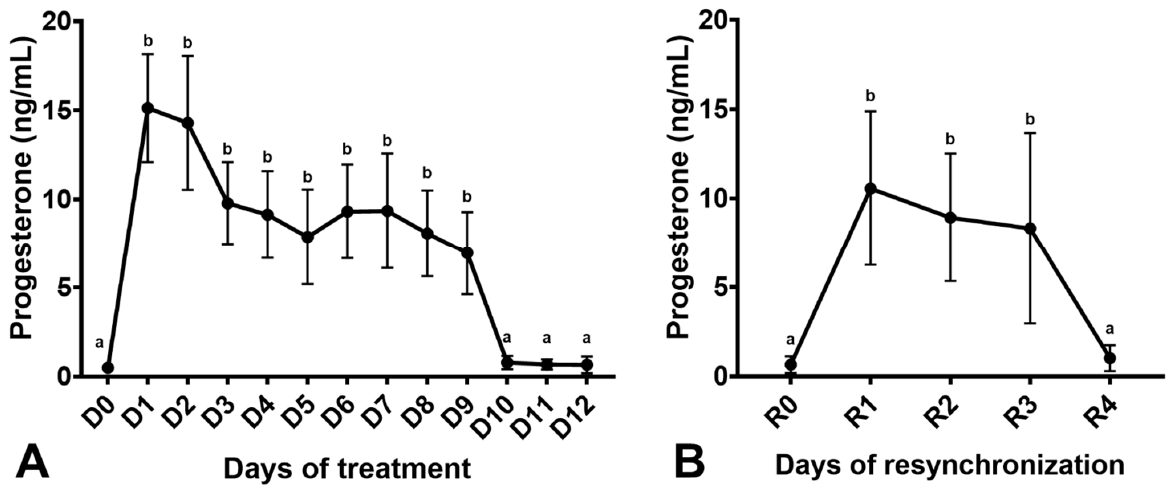
Figure 5. Serum progesterone concentration at 2, 6, and 12 h after insertion ( A ), and removal ( B ) of intravaginal proges ‐ terone ‐ releasing device (IPRD) in acyclic mares (n = 12). Acyclic mares were treated with estradiol ‐ 17 β for 3 days and then given an IPRD (A, 0 h). The IPRD was kept for nine days and was then removed (B, 0 h).